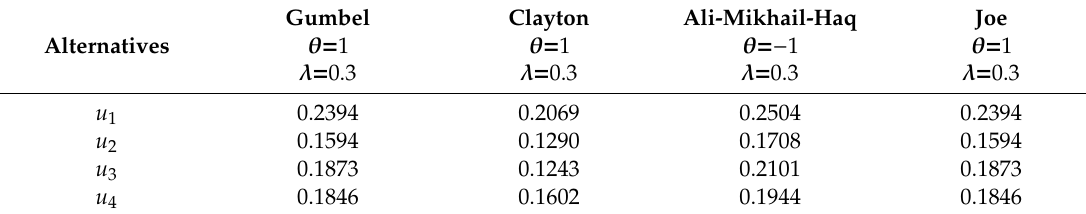
Table 9. The score function’s results using IFACWGA w